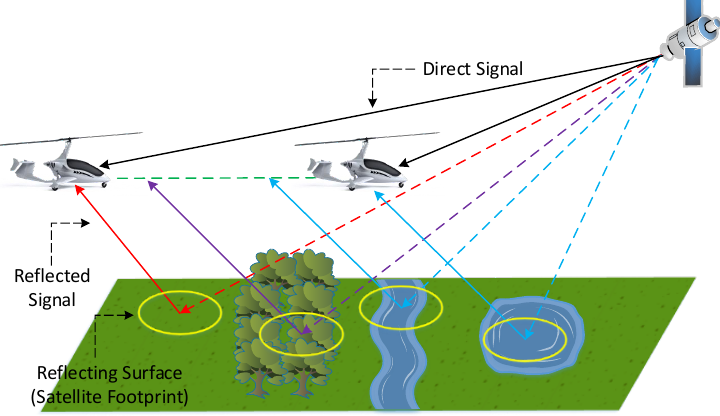
Figure 1. Airborne GNSS-R